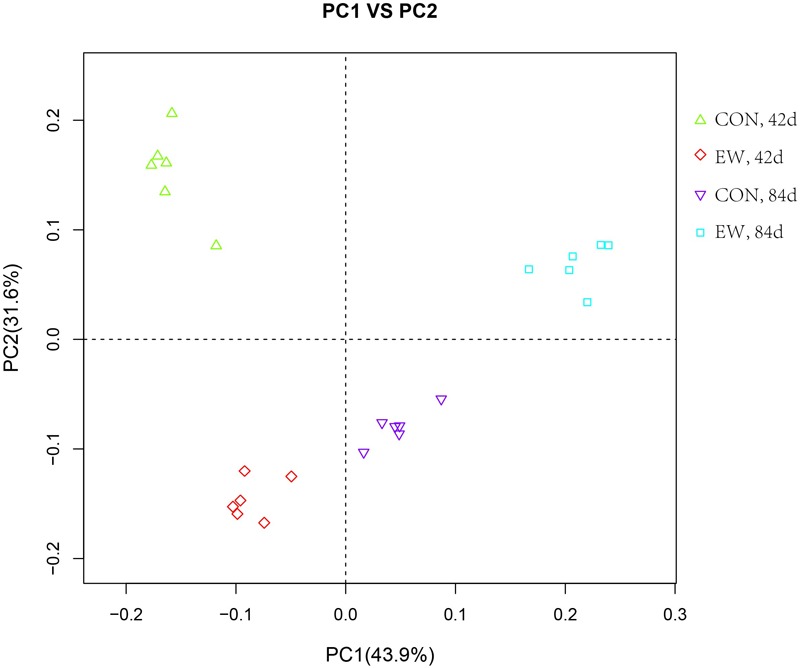
Principal coordinate analysis (PCoA) of the ileal bacterial OTUs in different groups.